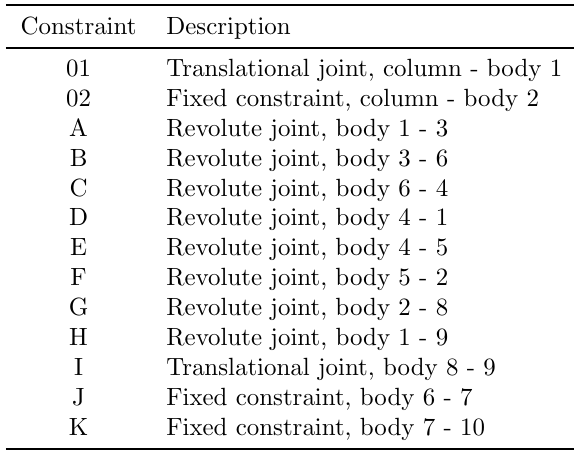
Table 1: Kinematic